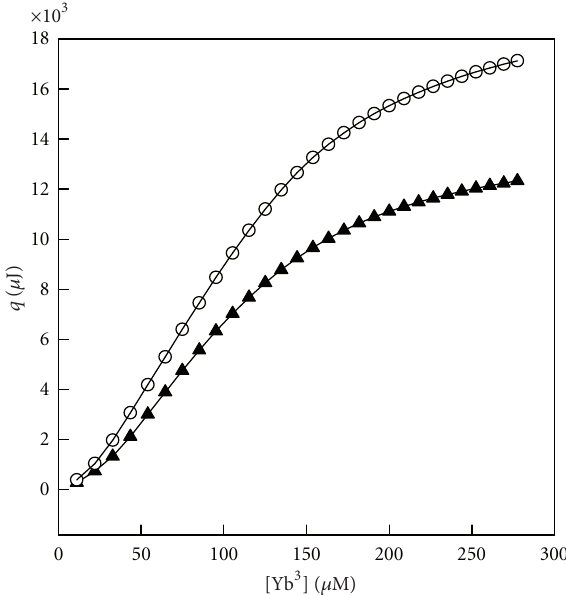
F 1: Comparison between the experimental heat (